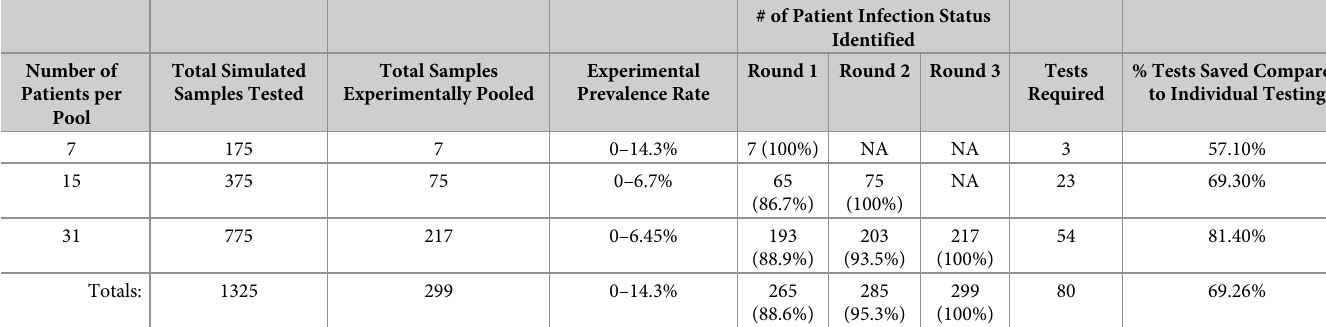
Table 2. Compressed sensing decoded pooled testing significantly decreases the number of tests required to identify infected samples.